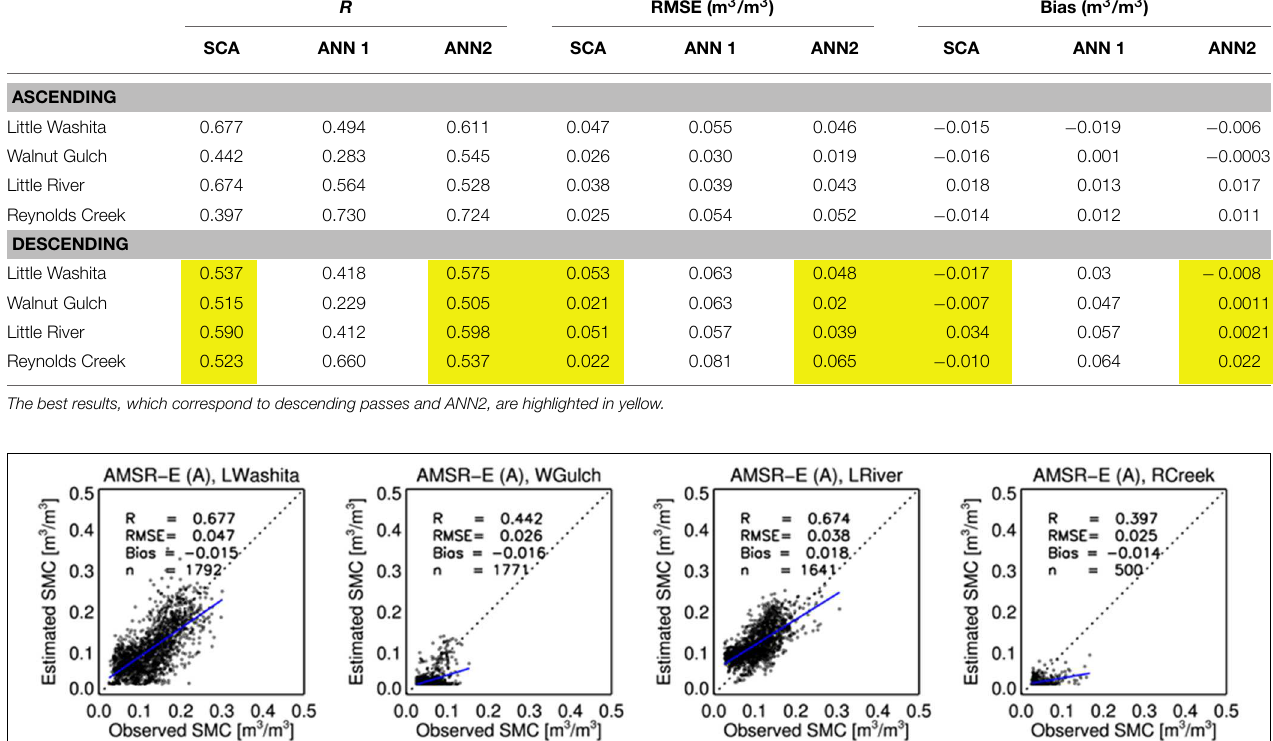
TABLE 1 | Comparison of the performances of the SCA and the two ANN of the HydroAlgo soil moisture algorithms in terms of R, RMSE, and bias for both ascending and descending orbits.